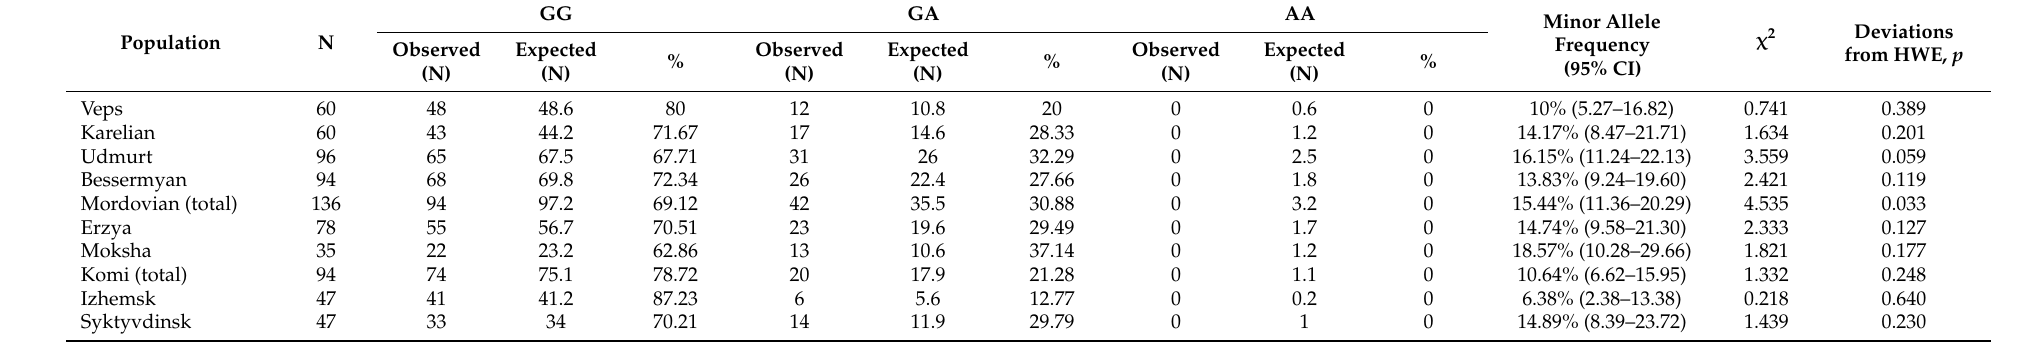
Table 6. Distribution of the rs3892097 genotypes of the CYP2D6 gene in the Finno-Permic populations of the Russian Federation.